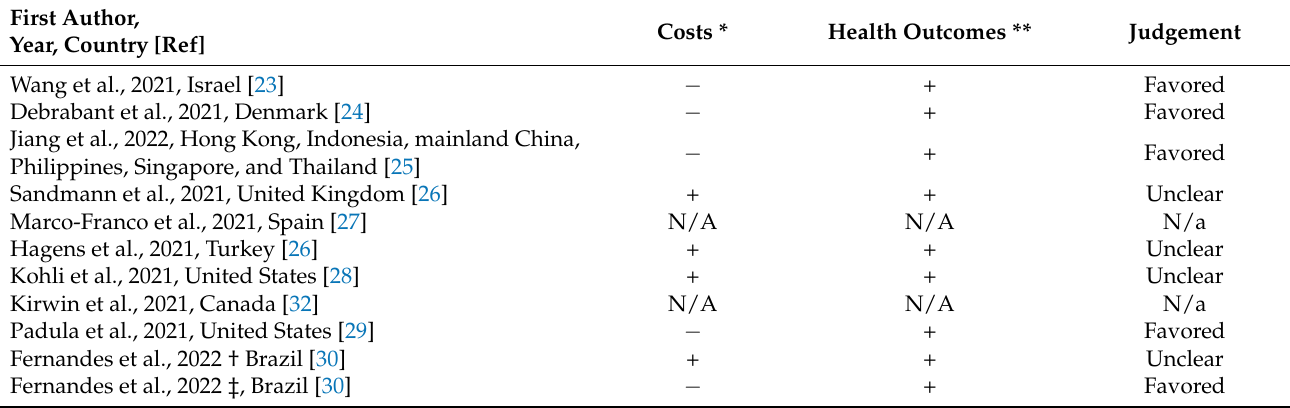
Table 3. Three-by-three dominance ranking